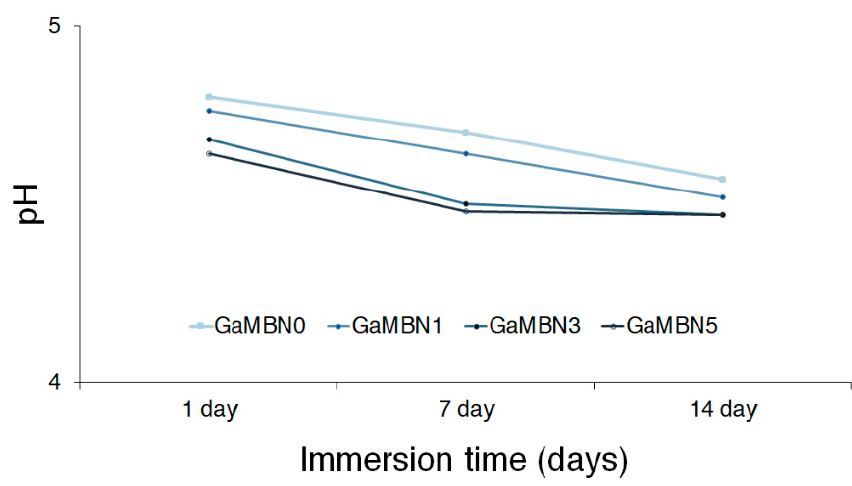
Figure 5. Relationship between pH and immersion time for the resin disks containing 0, 1, 3, and 5 wt% GaMBN: GaMBN0, GaMBN1, GaMBN3, and GaMBN5, respectively.